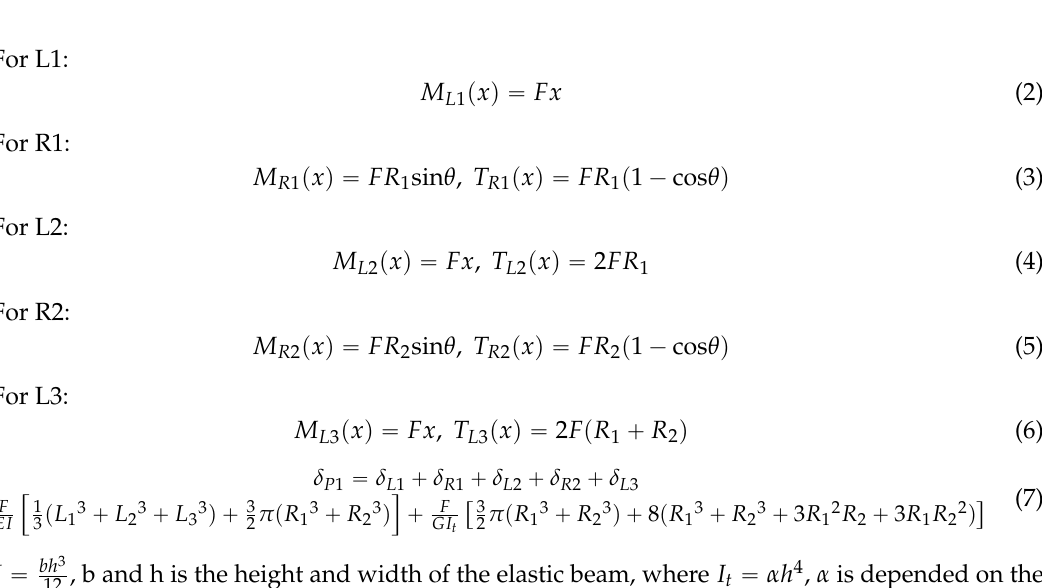
Figure 4. The structure and parameters of the beam.